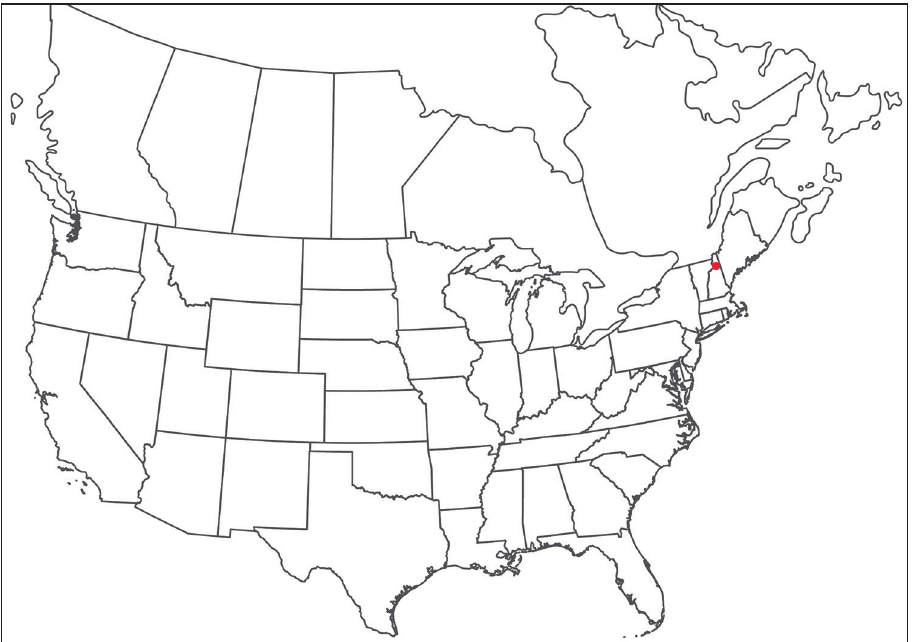
Figure 81. Torrenticola folkertsae sp. n.